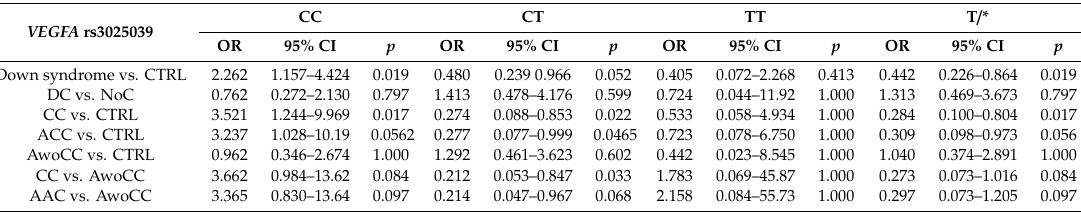
Table 10. Statistical analyses of di ff erences in genotype frequencies between patient and control groups. CC CT VEGFA rs3025039